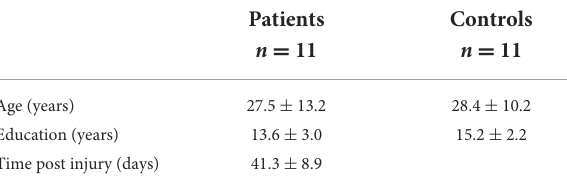
TABLE 1 Demographic results of TBI and healthy